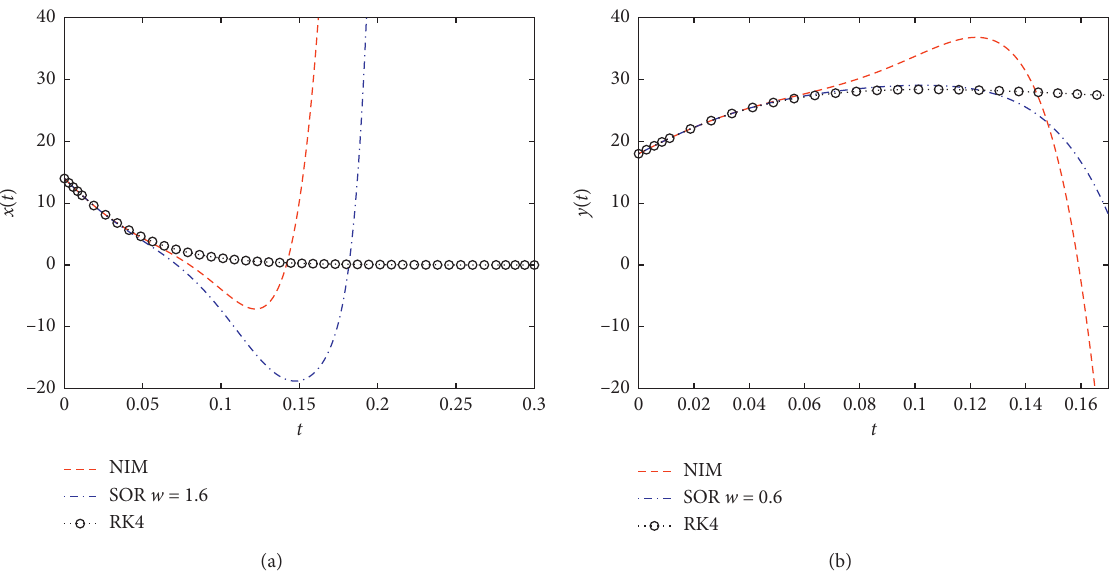
Figure 3: Case 1: comparison of three-term approximation SOR-like new iterative method, NIM, and RK4 for x ( t ), y ( t ), and ω